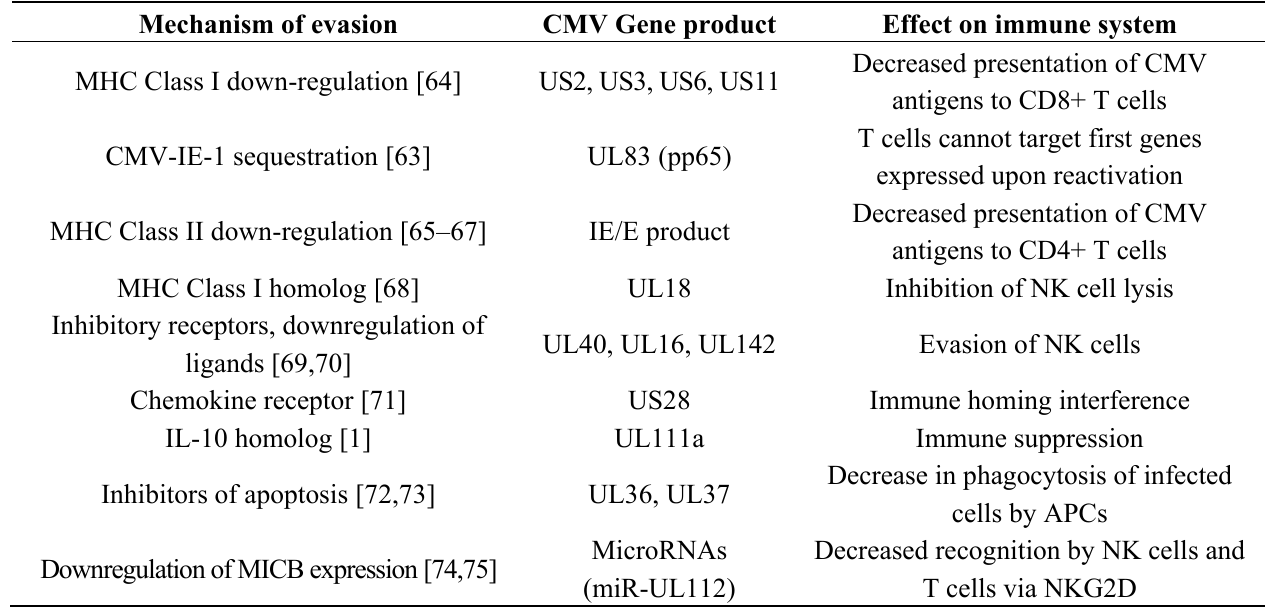
Table 1. CMV genes involved in immune